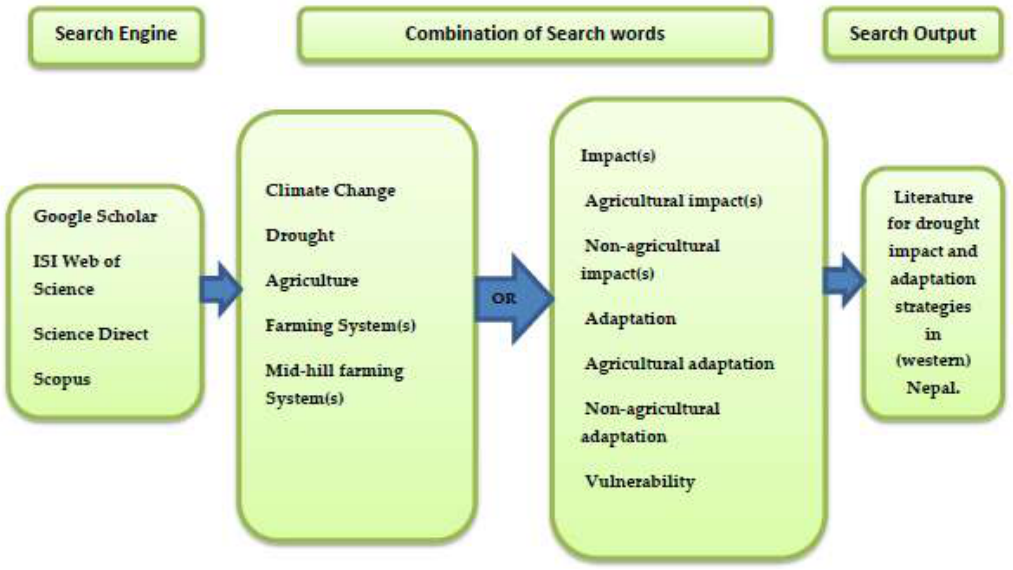
Figure 1. Methodology adopted for literature search using keywords in various web-based databases.